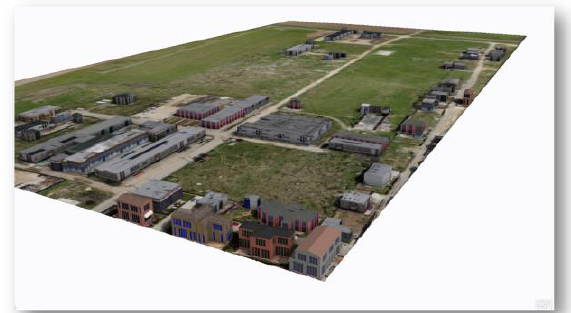
Figure 12. Simulation of the existing